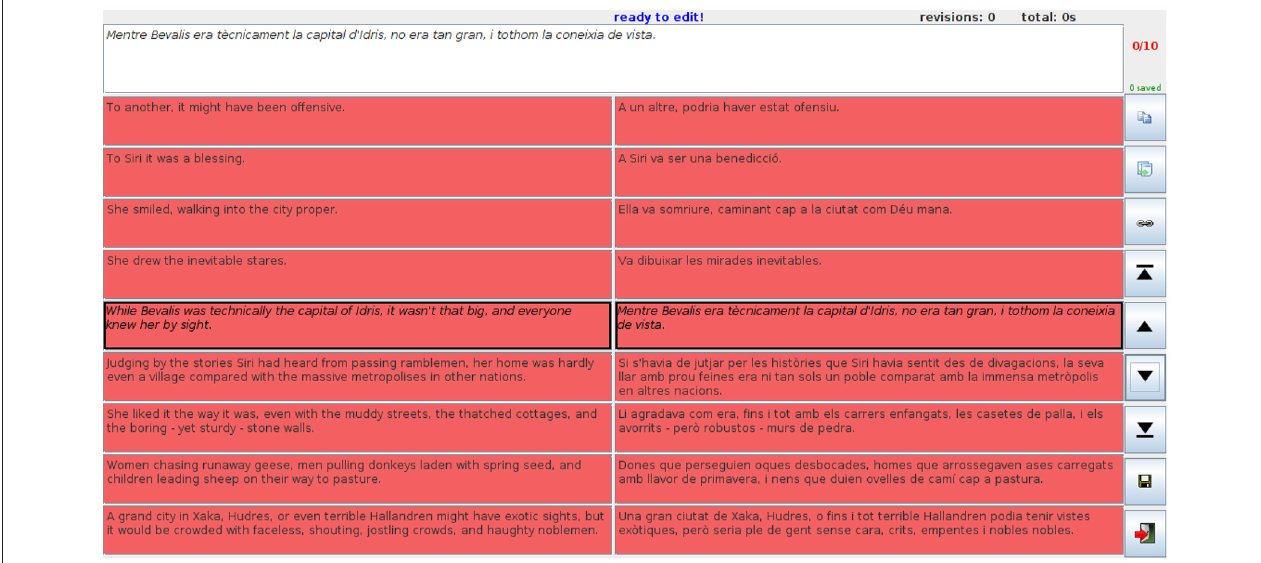
FIGURE 1 | Snapshot from the translation environment showing the third task, in which the translator is to post-edit the translations produced by the NMT system for sentences 21–30 of the